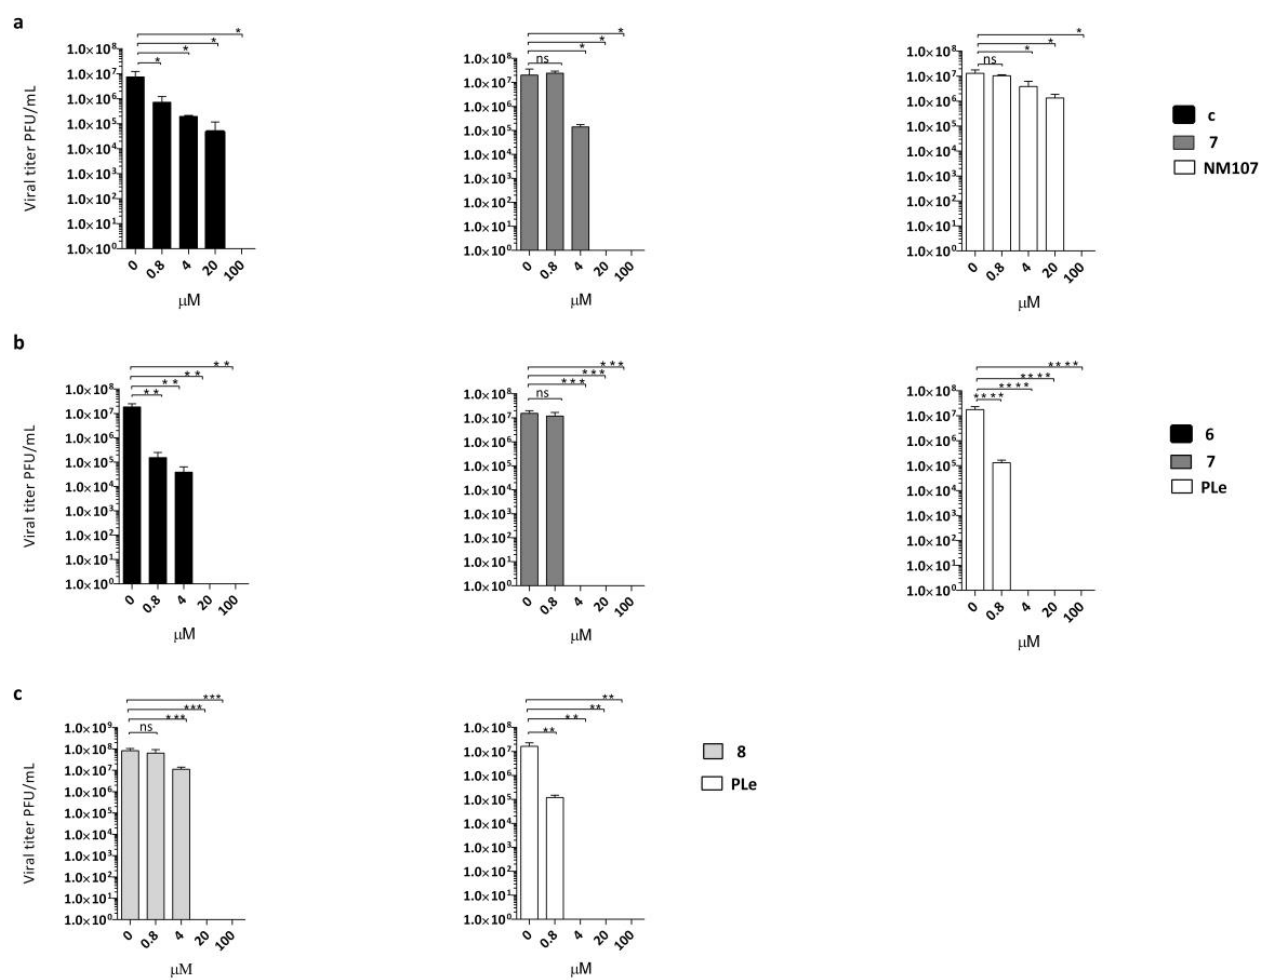
Figure 2. Dose-dependent reduction of ( a ) CVB3 titer in the presence of different concentrations of compound 6 (black bars) or compound 7 (dark grey bars) compared with untreated infected (no inhibitor) control and NM107 as reference (white bars) or ( b ) CVB4 titer in the presence of the same multiple concentrations of compound 6 (black bars) and compound 7 (dark grey bars), with pleconaril (PLe) used as reference control (white bars). ( c ) E9 titers in the presence of different concentrations of compound 8 (light grey bars); PLe used as reference control (white bars). The statistical significance values were defined as * p< 0.05, ** p< 0.01, and *** p< 0.001, **** p< 0.0001. Data represent mean ± standard deviation (SD) values of three independent determinations.